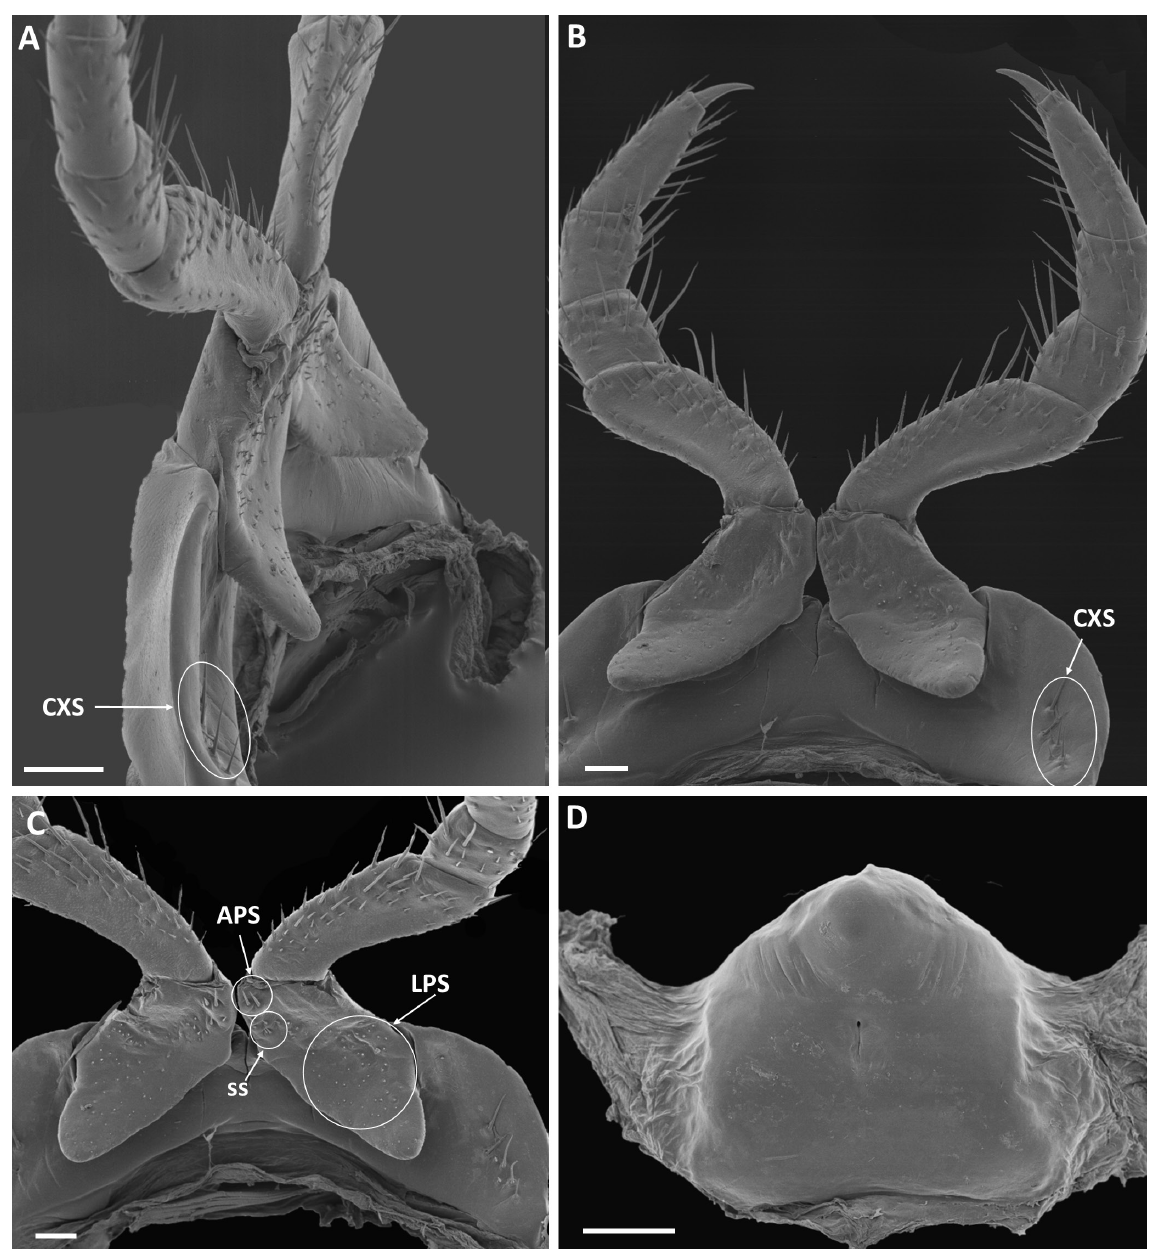
Fig. 34. Chaleponcus soerensenae sp. nov., holotype, ♂ (NHMD 621735). A–C . First pair of legs. A. Sublateral view. B. Anterior view. C. Subventral view. D . Sternum 9. Abbreviations: APS = mesapical prefemoral setae; CXS = coxosternal setae; LPS = lateral prefemoral sensilla; ss = smaller prefemoral setae. Scale bars = 0.1